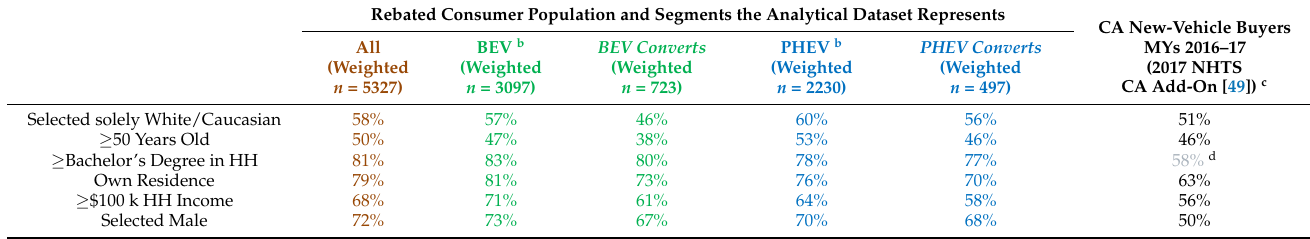
Table 4. Summary of EV Convert Characteristics a .